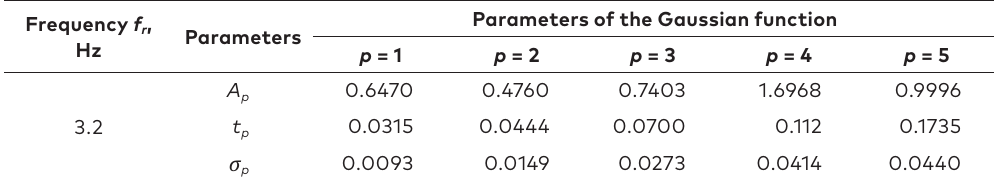
Table 8. Parameters of the template for running frequency of 3.2